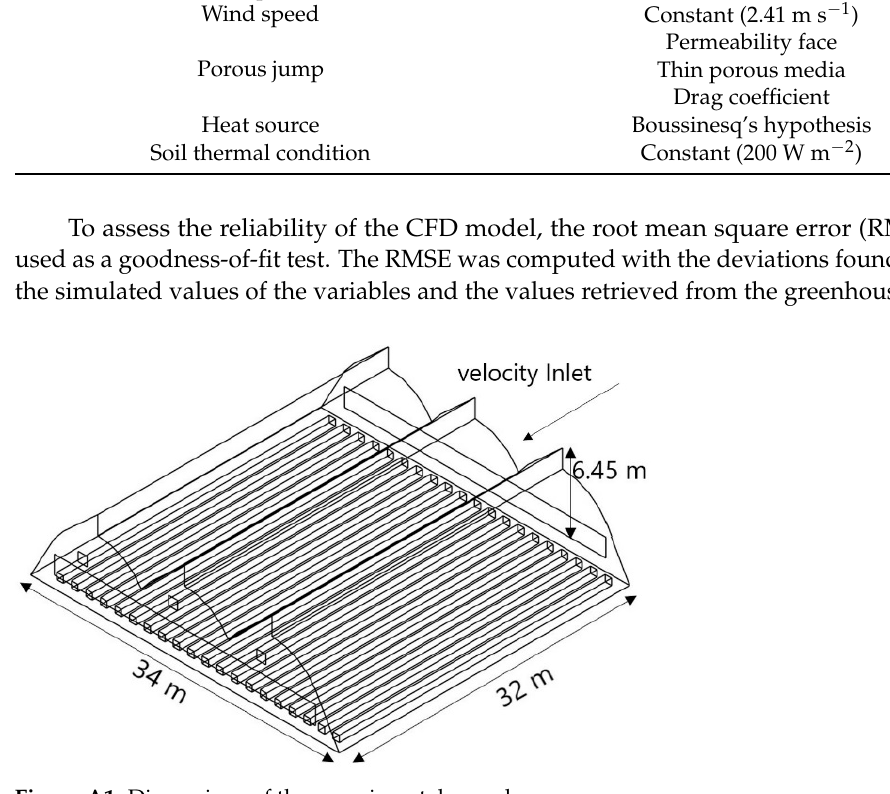
Table A1. Setting and boundary conditions of the CFD model.